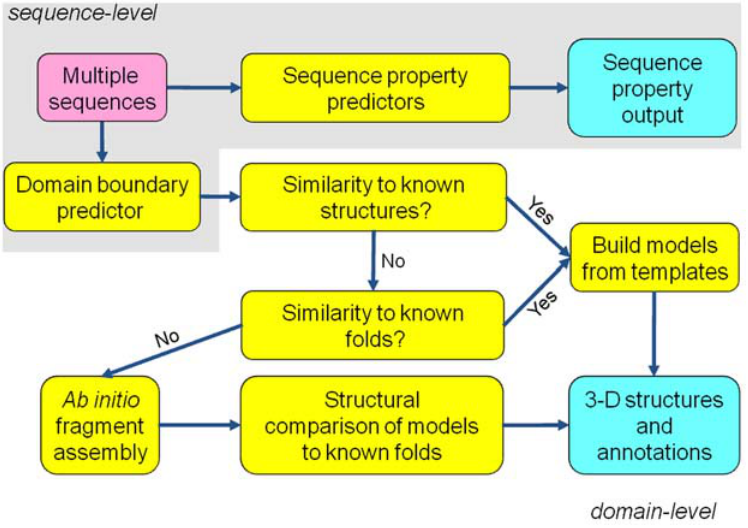
Figure 1. Workflow for the protein structure prediction pipeline given a single query sequence.